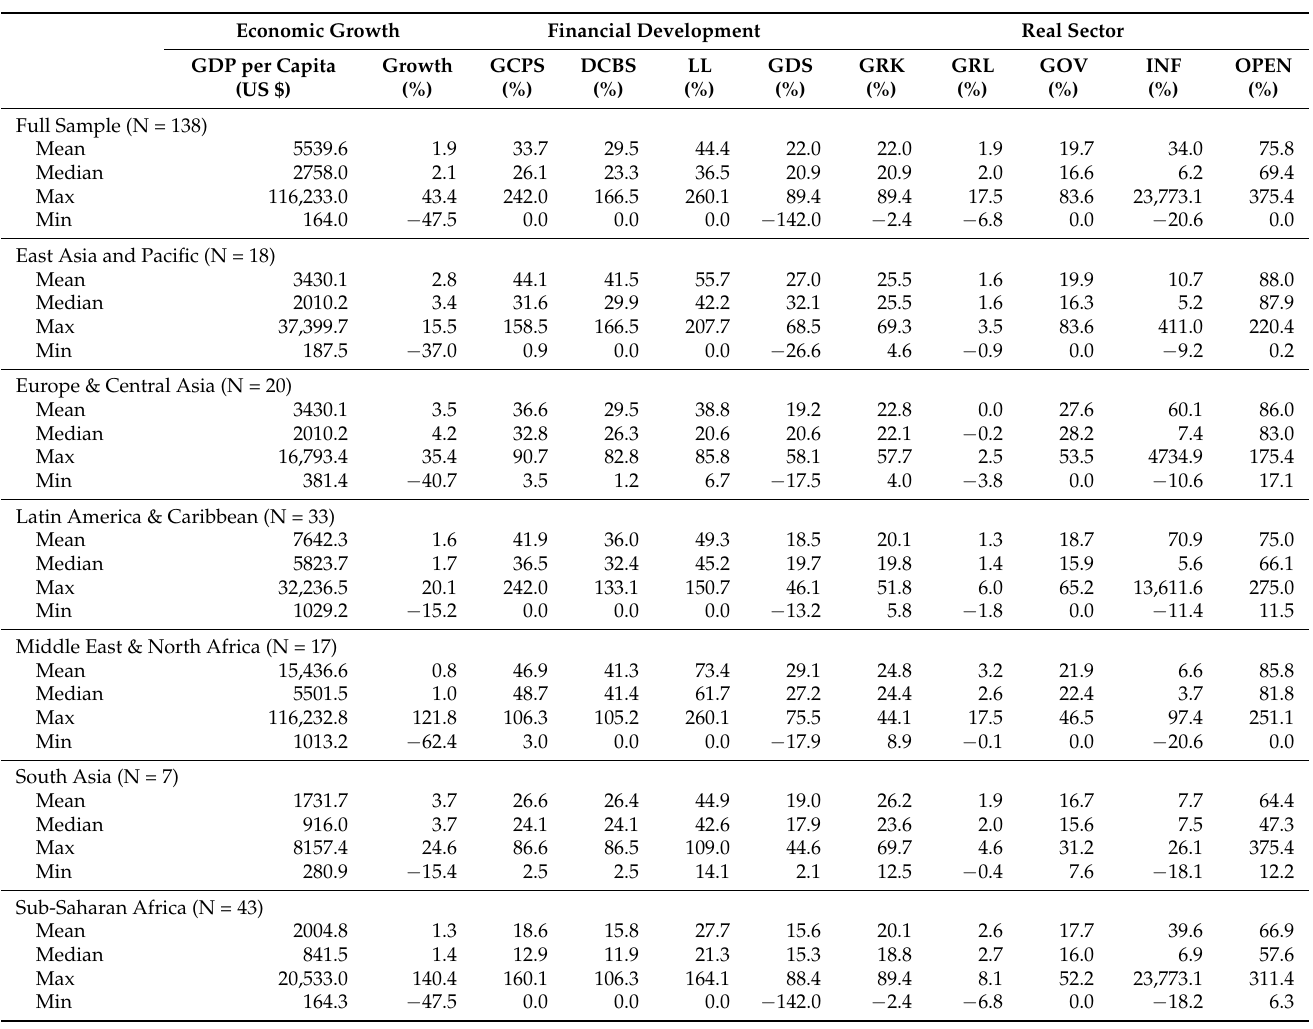
Table 1. Summary statistics by region